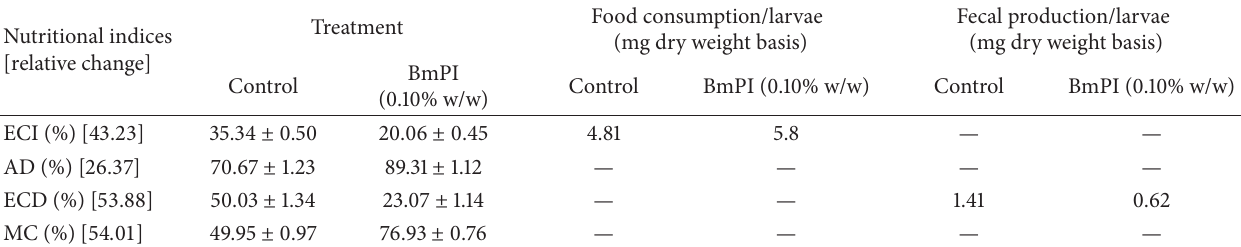
Table 4: Nutritional indices for H. armigera fourth-instar larvae fed on BmPI and control diet ( 𝑛 = 52 ). Treatment Nutritional indices [ relative change ] Control (0.10% w/w) ECI (%)